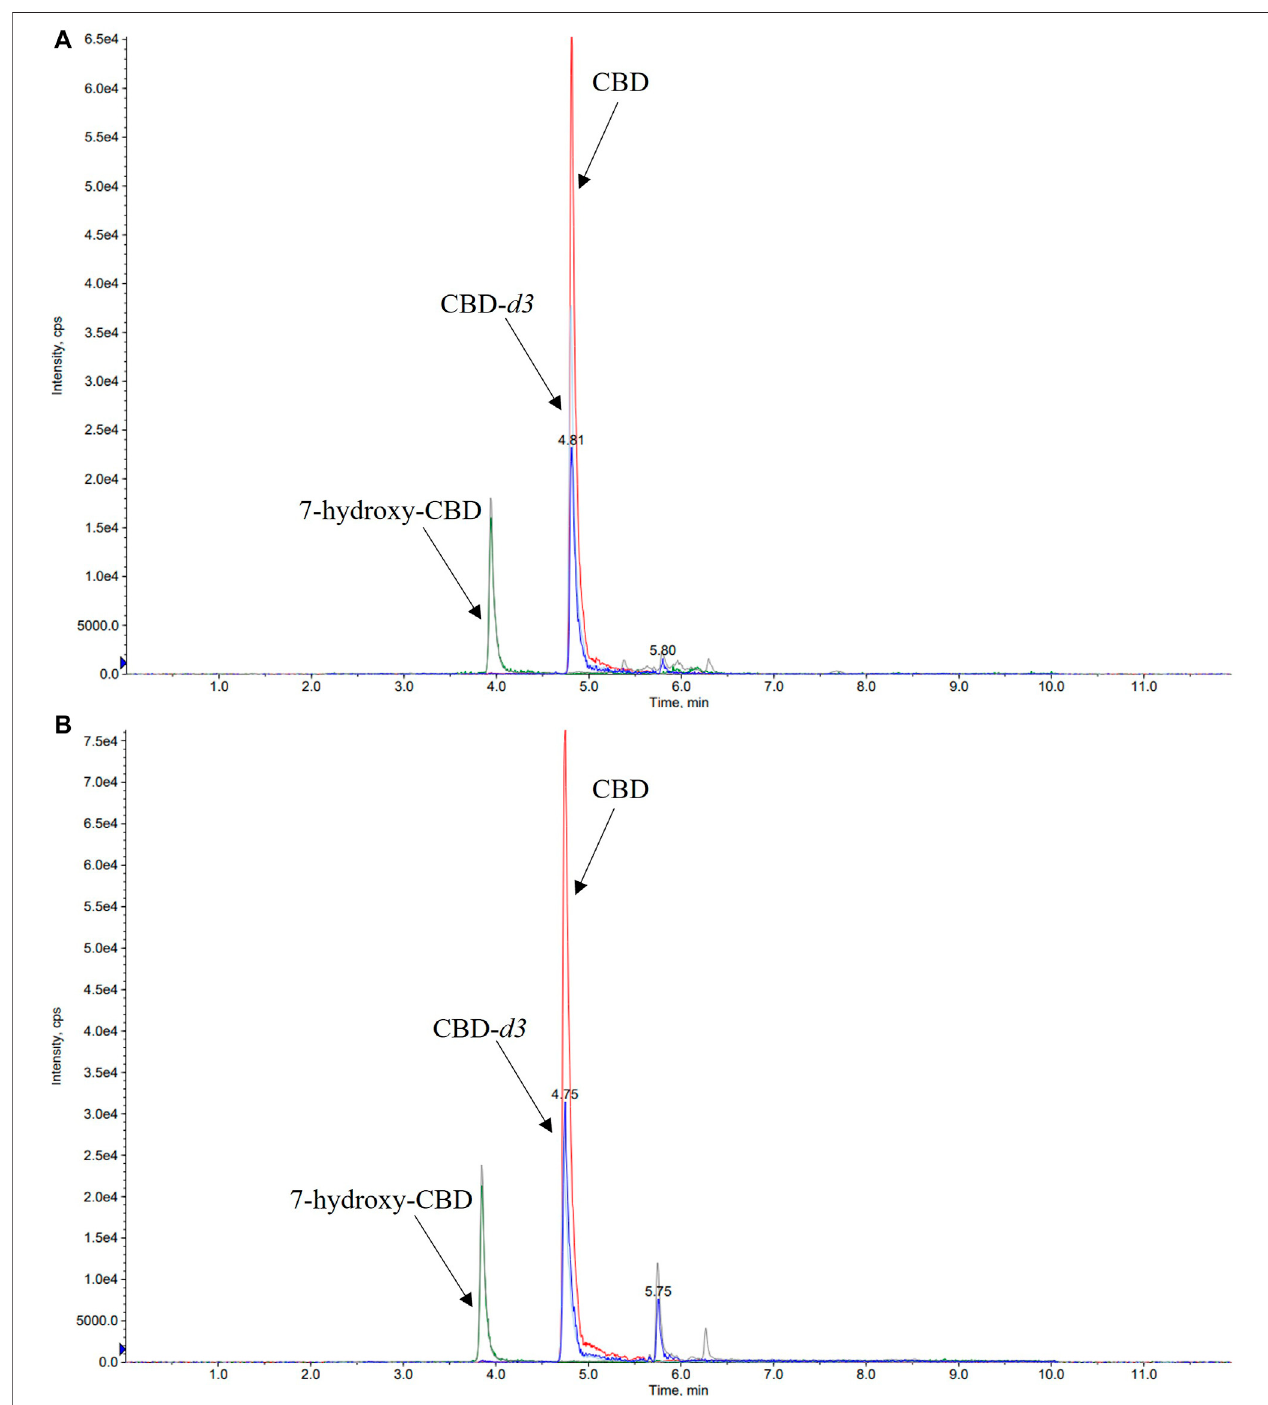
FIGURE 3 | Representative chromatograms of medium QC (quality control sample spiked with CBD 350 ng/ml, 7-hydroxy-CBD 175 ng/ml and cannabidiol- d3 170 ng/ml) serum (A) and saliva (B) samples. CBD, cannabidiol.